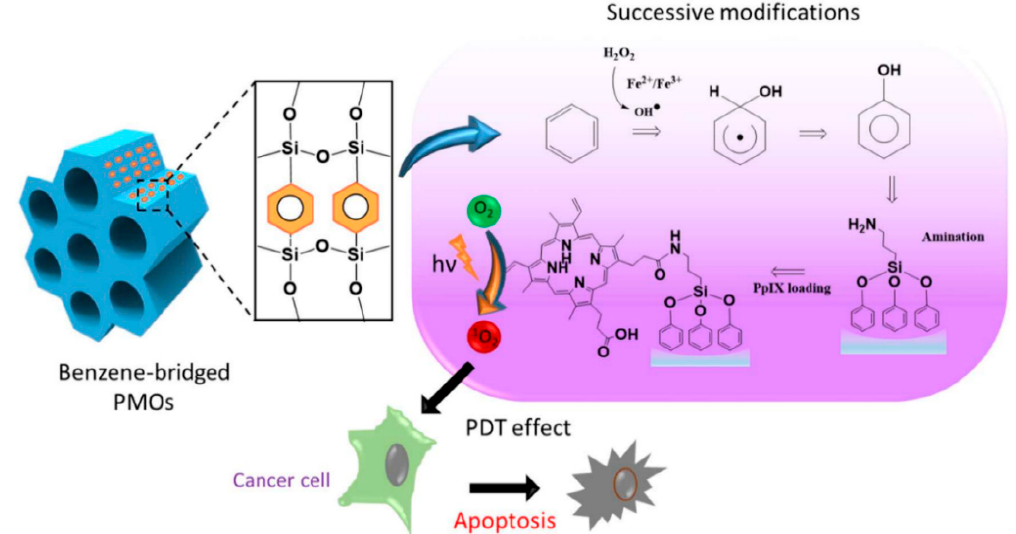
Figure 5. The reaction pathway of the hydroxylation of benzene and protoporphyrin IX loading and the mechanism elucidating the light-induced biological effects (Apoptosis). Reprinted from [56], MDPI Publications, 2020.